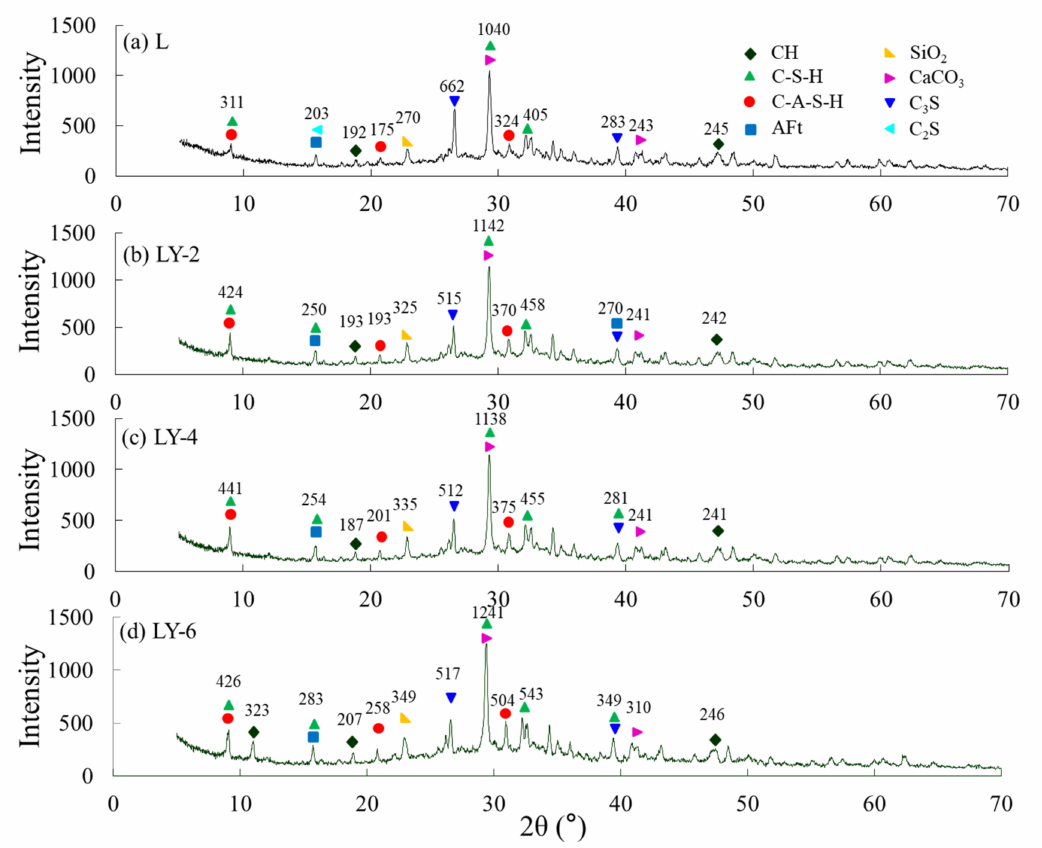
Figure 13. XRD patterns of samples at 28 days: ( a ) L; ( b ) LY-2; ( c ) LY-4; ( d )